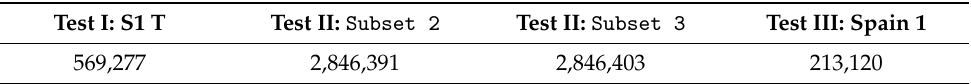
Table 4. Number of data points (Sentinel 2 pixels) of the respective test datasets used for evaluation the applied ML approaches. The numbers are exemplarily illustrated for the training on Uset 1 according to Figure 6.